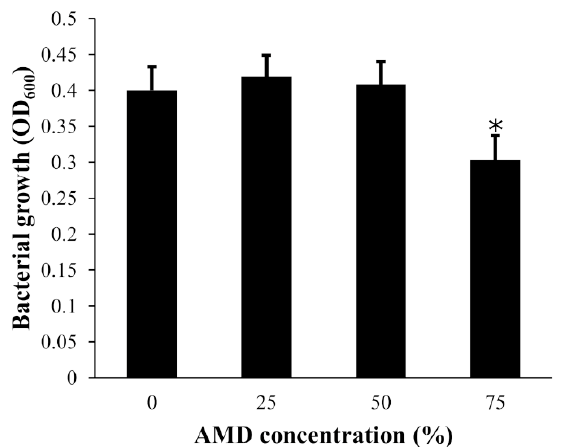
Figure 4. Average growth of Pelophylax perezi skin bacterial strains after being exposed to serial dilutions of acid mine drainage (AMD). Error bars represent standard deviation. * Statistically different from the control, p < 0.0001.